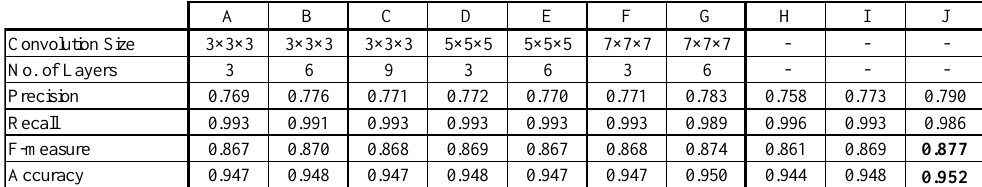
Table 3. Classification results by individual network (A-G) and integration (H-J)